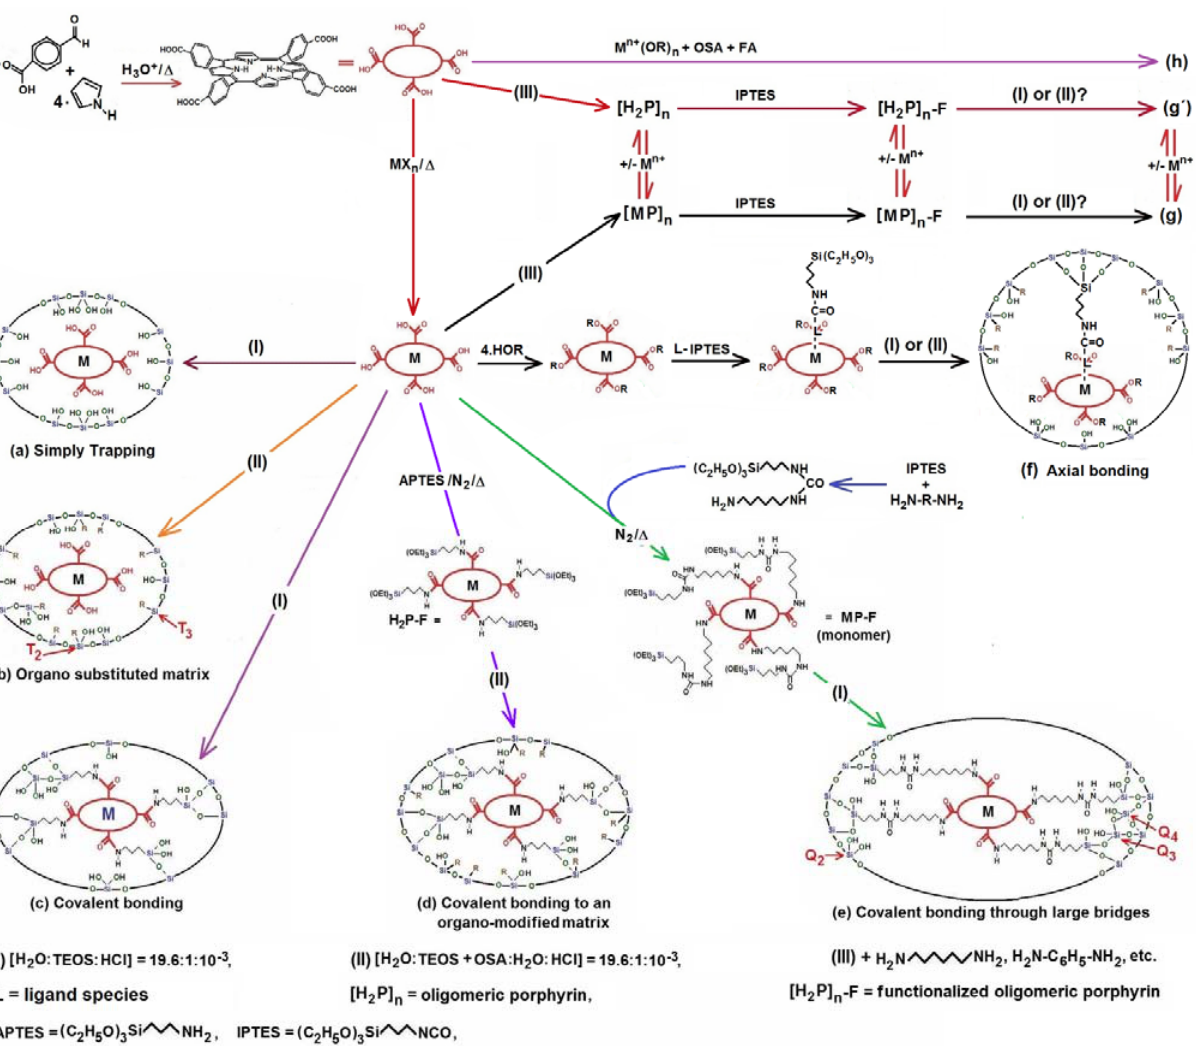
Figure 13. Routes suggested for encapsulating tetrapyrrole macrocycles (using the species H T(P-COOH)PP), as example within porous silica by: ( a ) physical trapping, ( b ) trapping 2 inside an organo-modified matrix, ( c ) covalent bonding, ( d ) covalent bonding inside an organo-modified matrix, ( e ) expansion of the pore cavity by means of attached diamines and functionalized alkoxides, ( f ) covalent bonding to the network through a functionalized axial ligand, ( g ) covalent bonding of oligomeric species, ( i ) trapping or bonding in different inorganic matrixes. T , T , Q , Q and Q , represent silicon groups detected by 2 3 2 3, 4 29